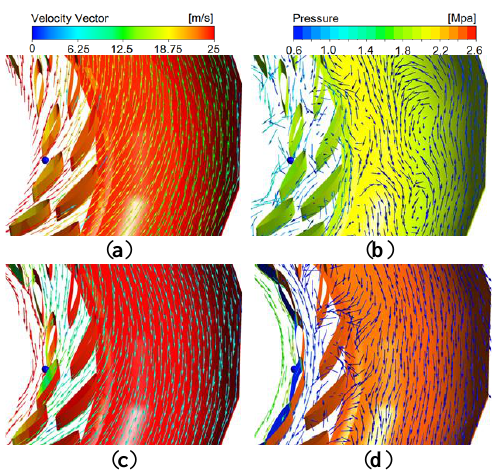
Figure 10. Flow fields between spiral case and guide vanes at different moments. ( a ) t = 0 s; ( b ) t = 6.5 s; ( c ) t = 12 s; ( d ) t = 33 s.